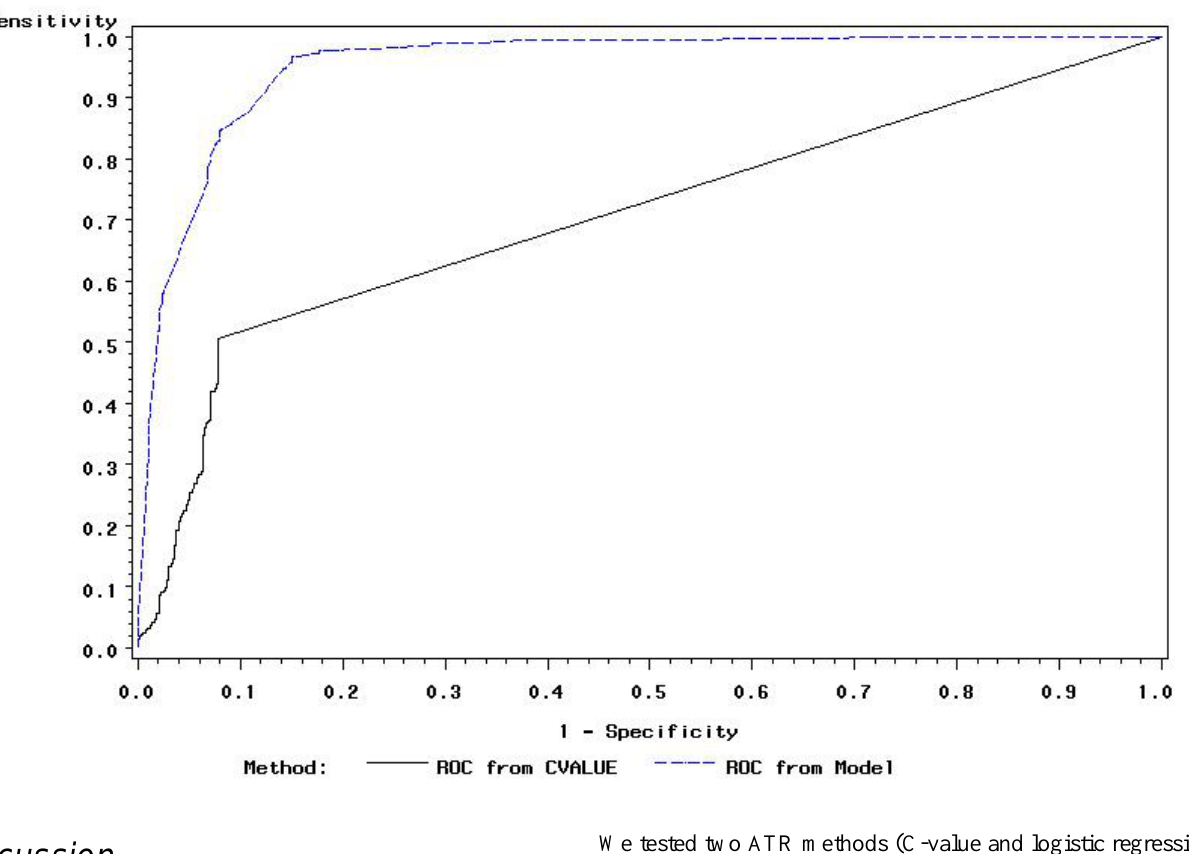
Figure 3. Curves for C-value and the regression